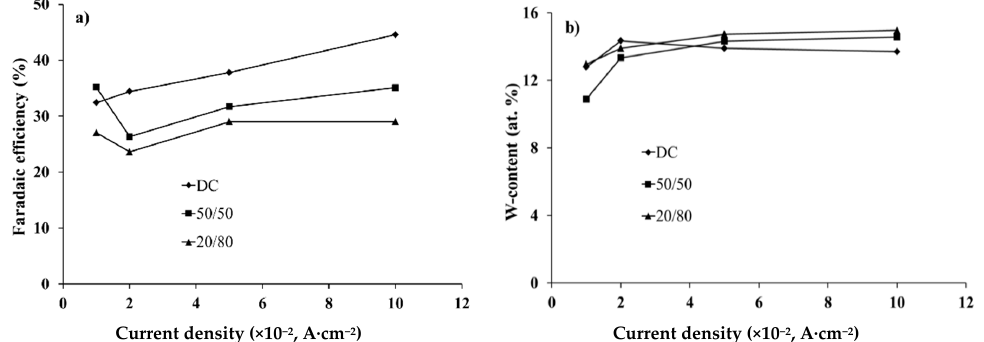
Figure 2. Faradaic efficiency ( a ), and W content ( b ) in Ni–W alloys versus the cathode current density in the DC and the pulse current modes with the different duty cycles (50% and 80%). The pH of the electrolyte is